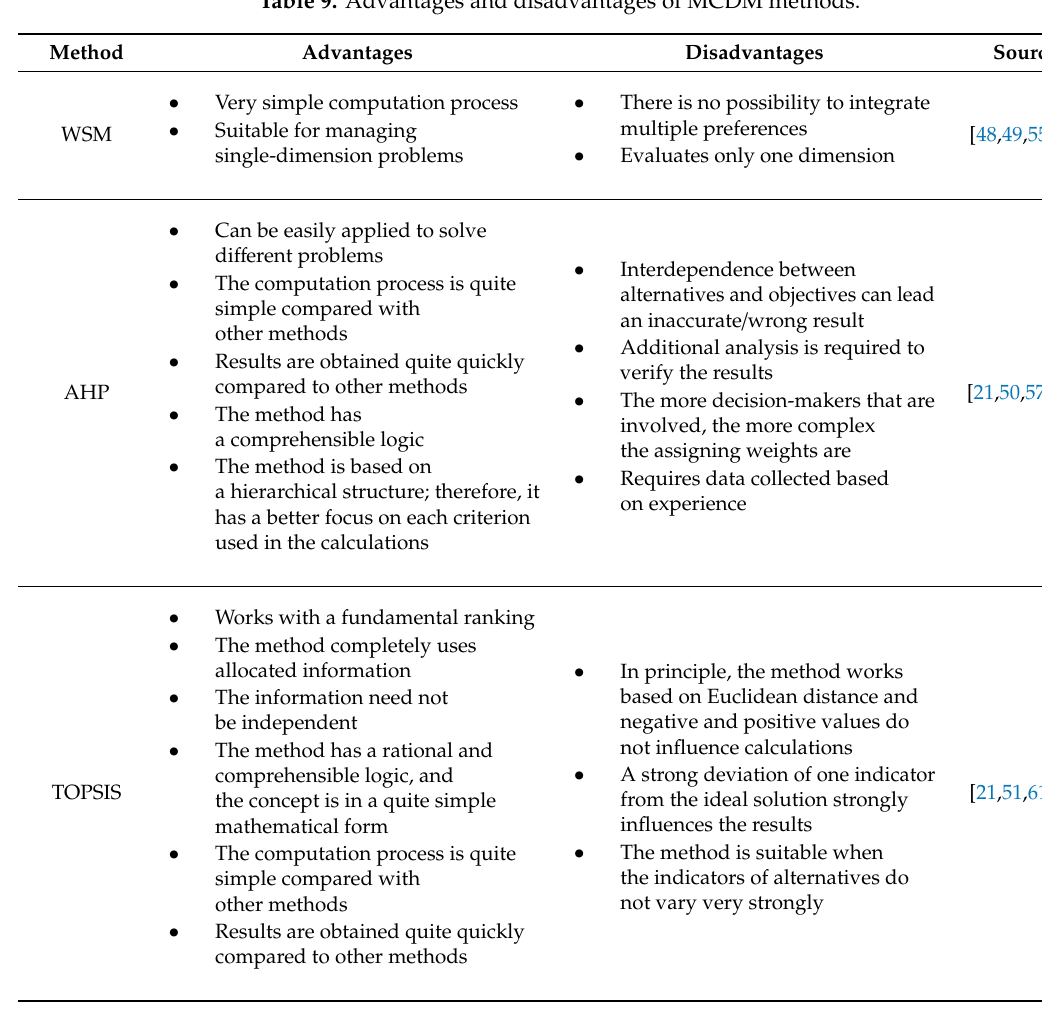
Table 9. Advantages and disadvantages of MCDM